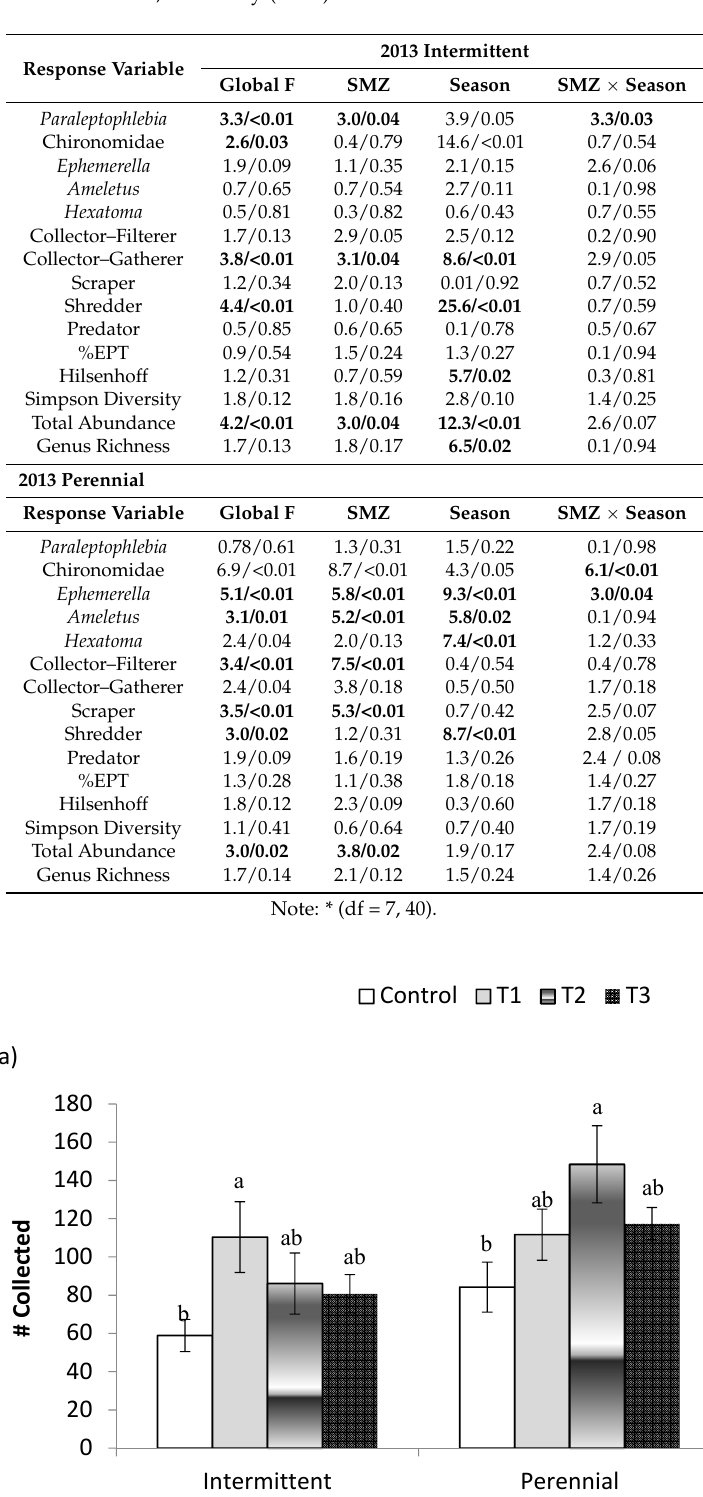
Table 3. Post-harvest effects * of SMZ treatment, season, and their interaction on benthic macroinvertebrate abundance at Robinson Forest, Kentucky